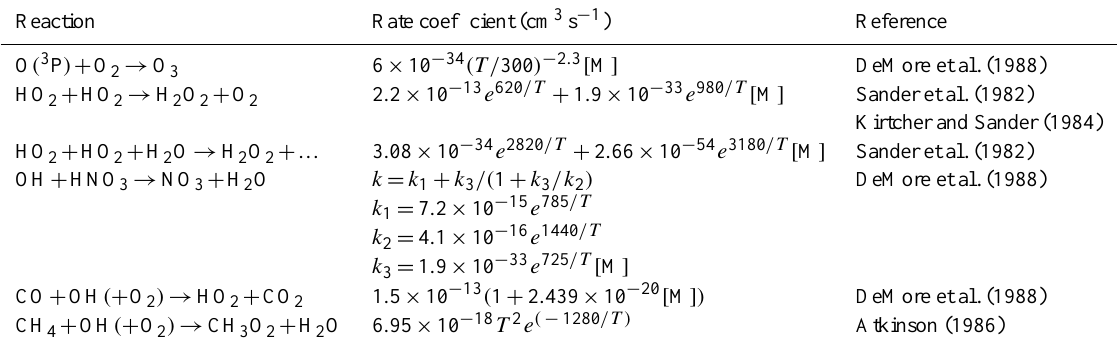
Table. C4. Gas phase reactions and rate coefficients (from the RADM2 chemical mechanism, Stockwell et al., 1990) used in this work with special rate expressions. T is the temperature in Kelvin and [ M ] the concentration of air molecules in cm − 3 .